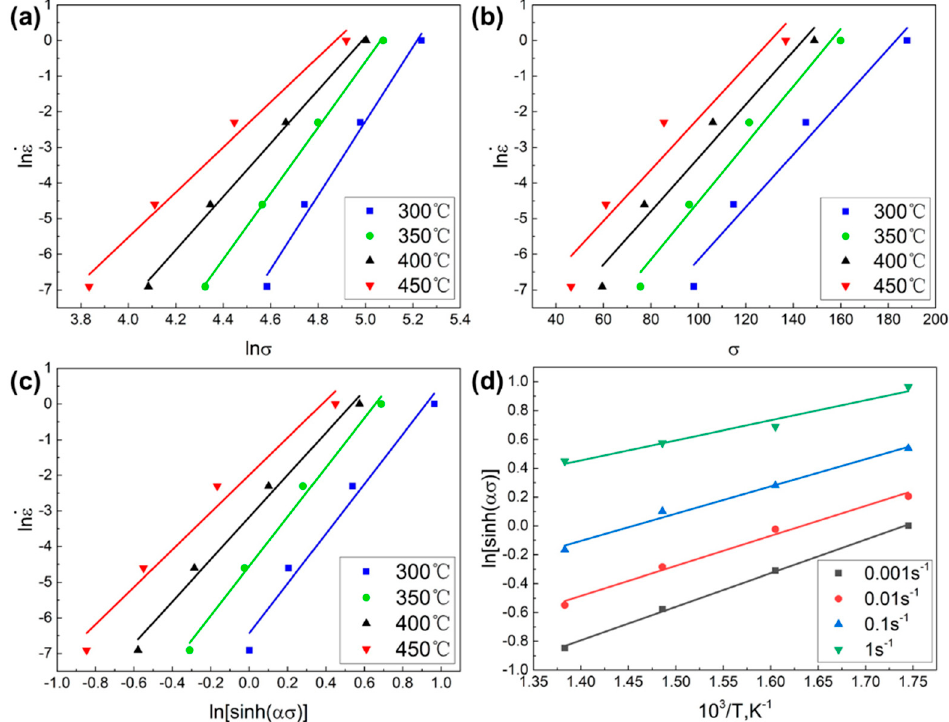
Figure 9. The relationship between the peak stress, strain rate and deformation temperature in the first layer of the deposited alloy: ( a ) ln ε ˙ ‐ ln σ s , ( b ) ln ε ˙ ‐ σ s , ( c ) ln ε ˙ ‐ ln[sinh( ασ )], ( d ) ln[sinh( ασ )] ‐ 1/T.